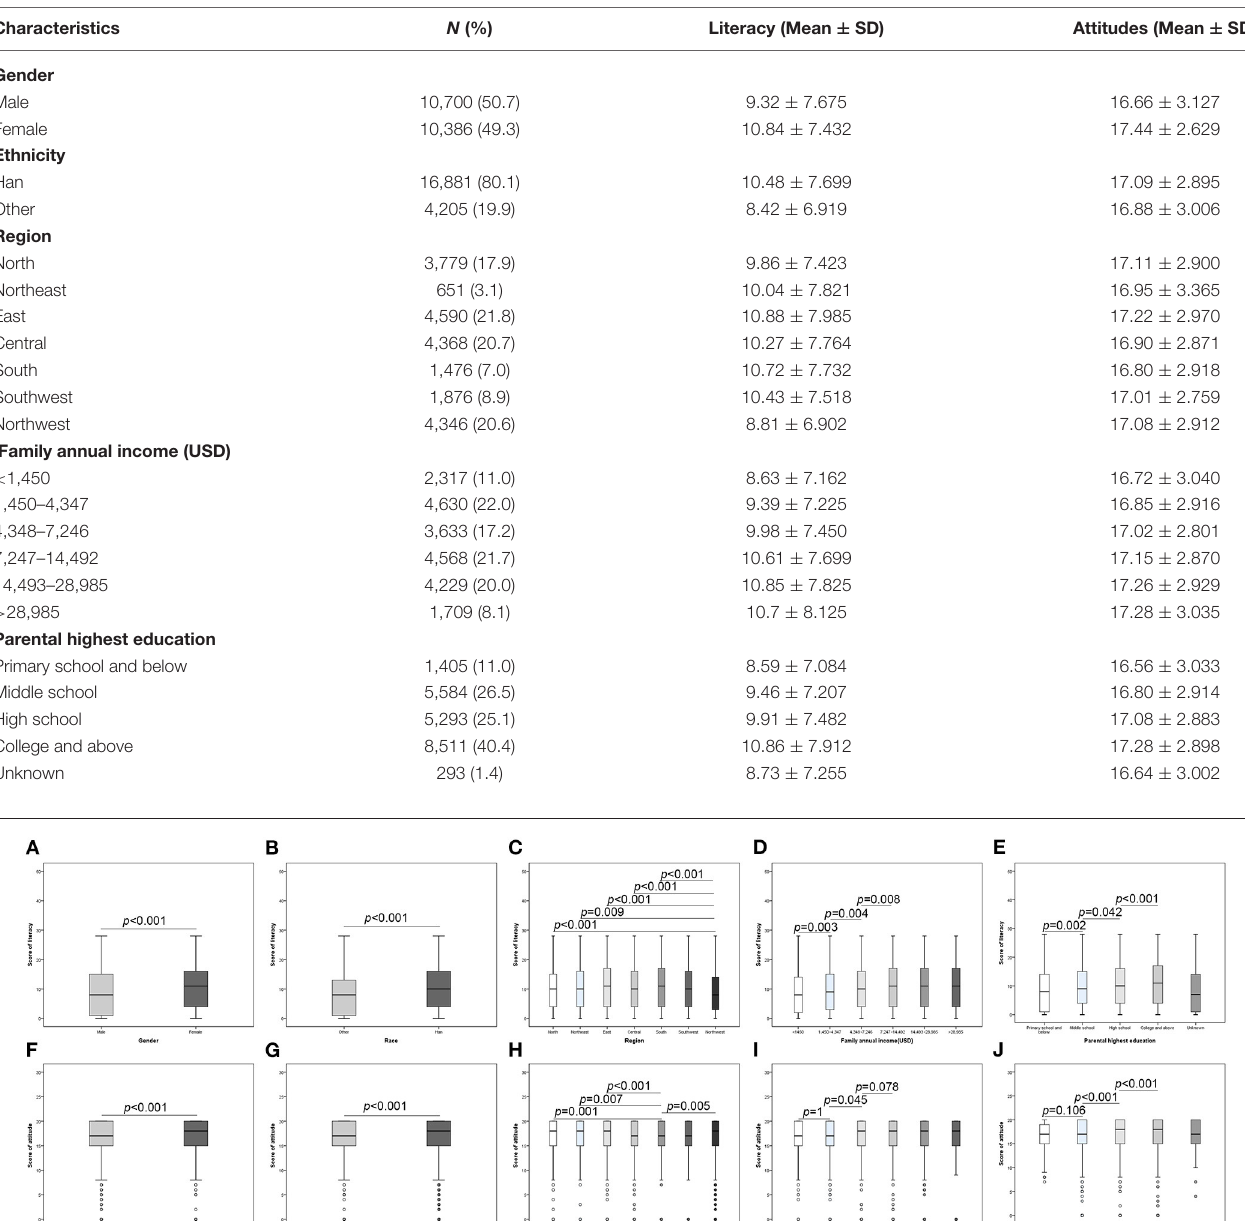
TABLE 1 | Distribution of participant characteristics.